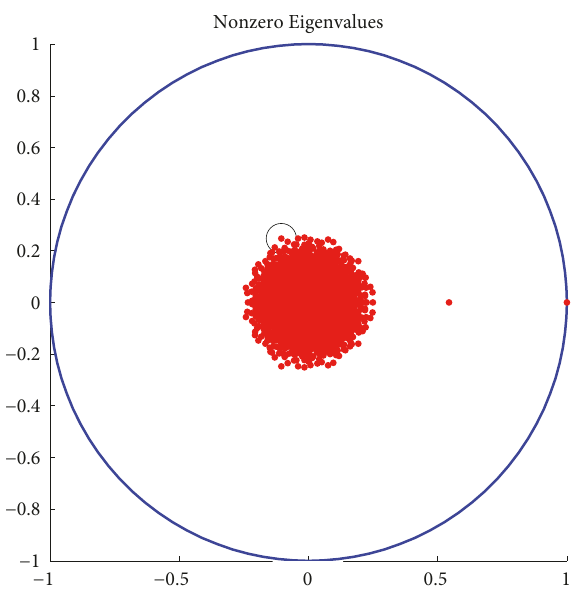
Figure 17: Nonzero eigenvalues for Gnutella peer to peer network after removing sources.